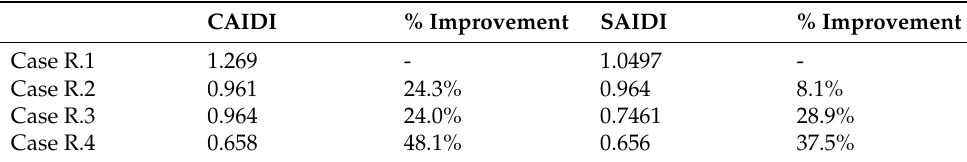
Table 6. Comparison of all reliability cases. Case R.1 is the base case.